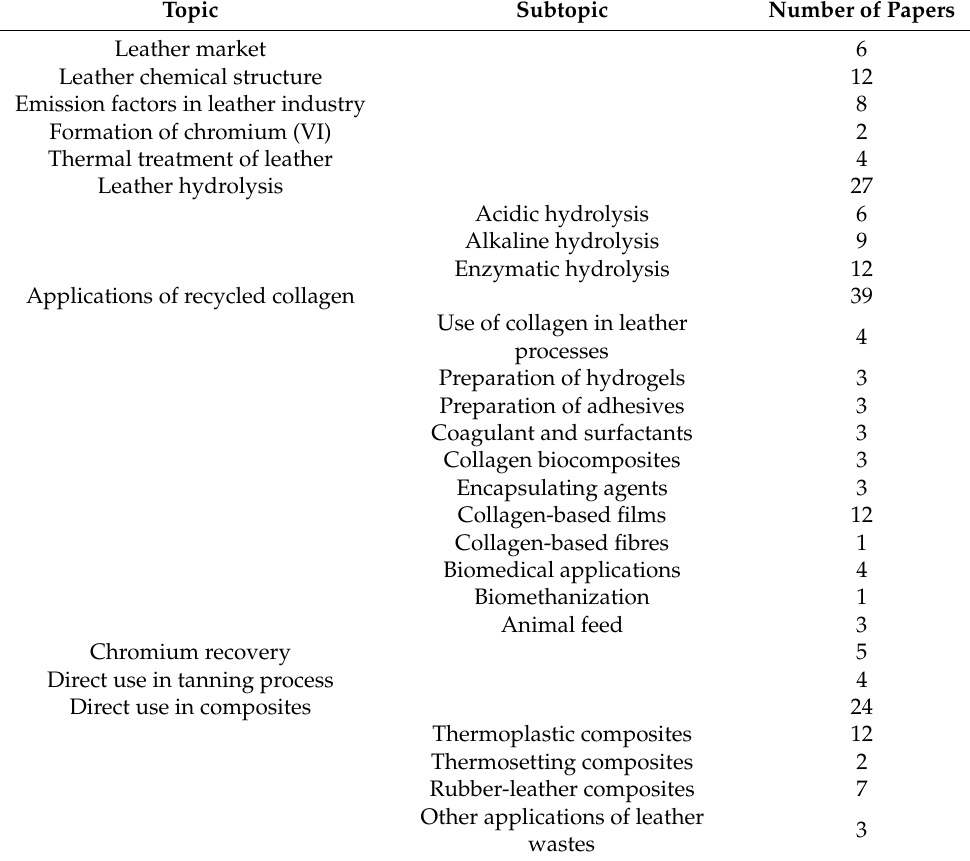
Table 1. Number of papers for topics and subtopics analyzed in this